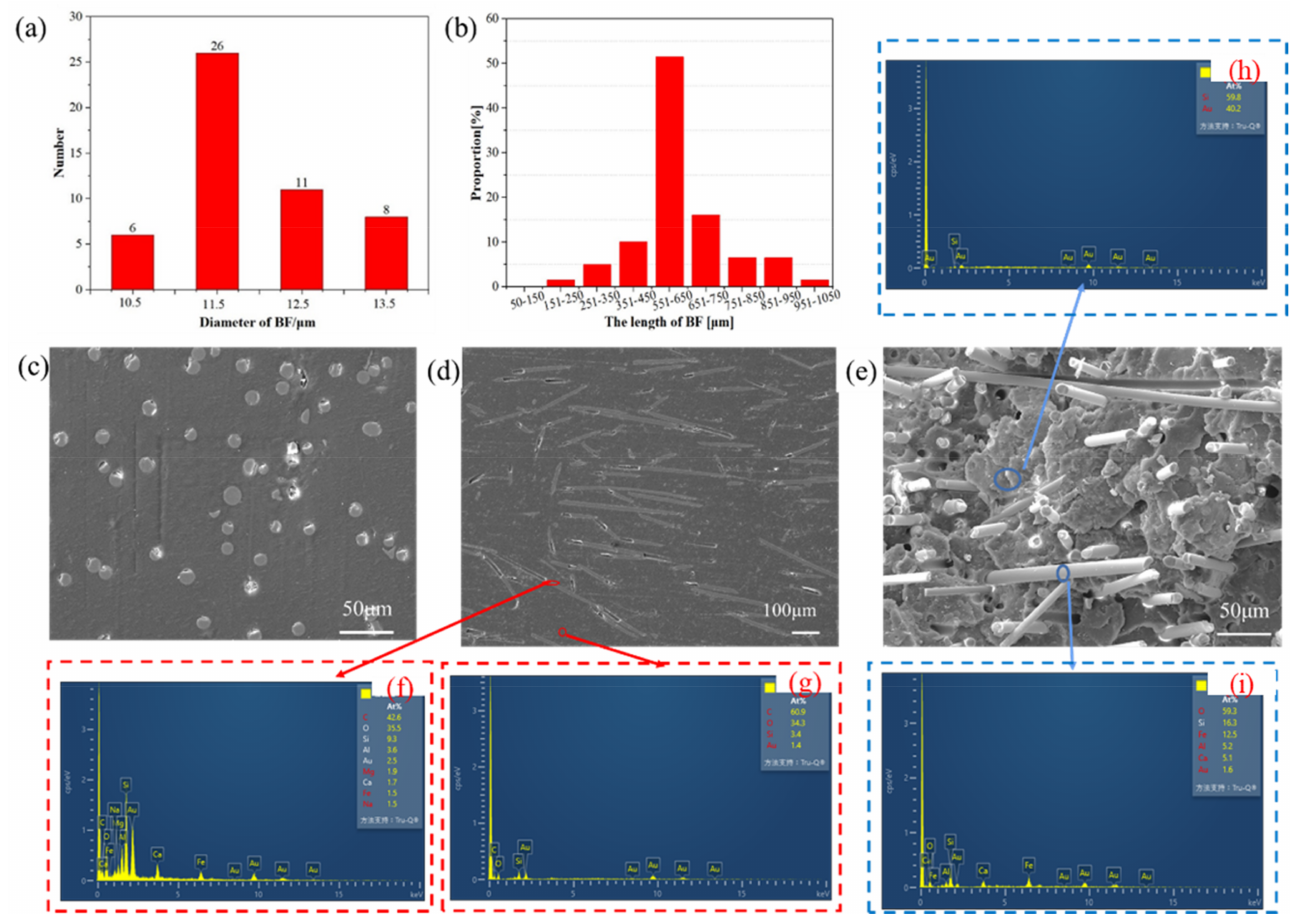
Figure 2. The structural characterizations of the PLA-based binary and ternary blends: ( a ) diameters from 10.5–13.5 µ m, ( b ) length of the BF, ( c ) the surface SEM micrographs of C2, and ( d ) the cross- sectional SEM micrograph of C2. ( f , g ) are the EDS from the SEM micrograph of ( d ), ( e ) is the tensile fracture morphology of C2, ( h , i ) are the EDS from the SEM micrograph of ( e ). The chemical structure of the polymers was confirmed by WAXS and FTIR (Figure